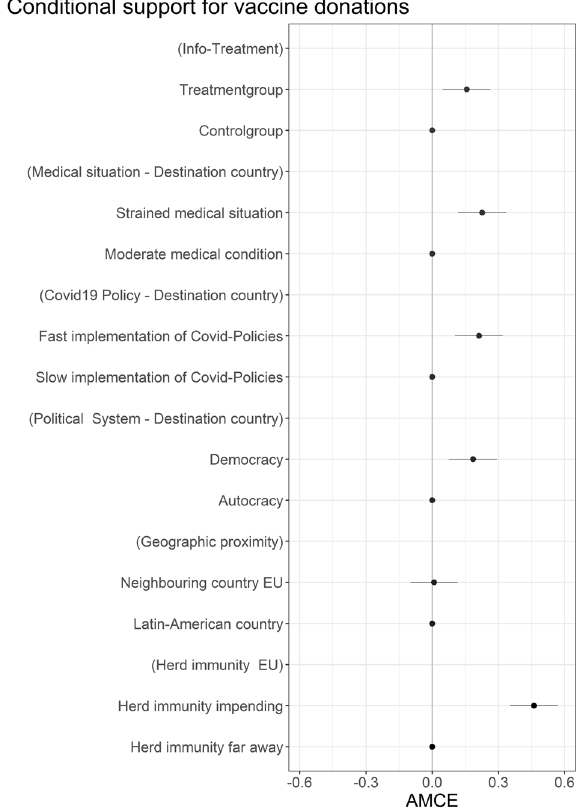
Fig. 2 Conditional public support for international vaccine solidarity. Average marginal component effects of experimental treatments. Data collected in Germany in May 2021, n =